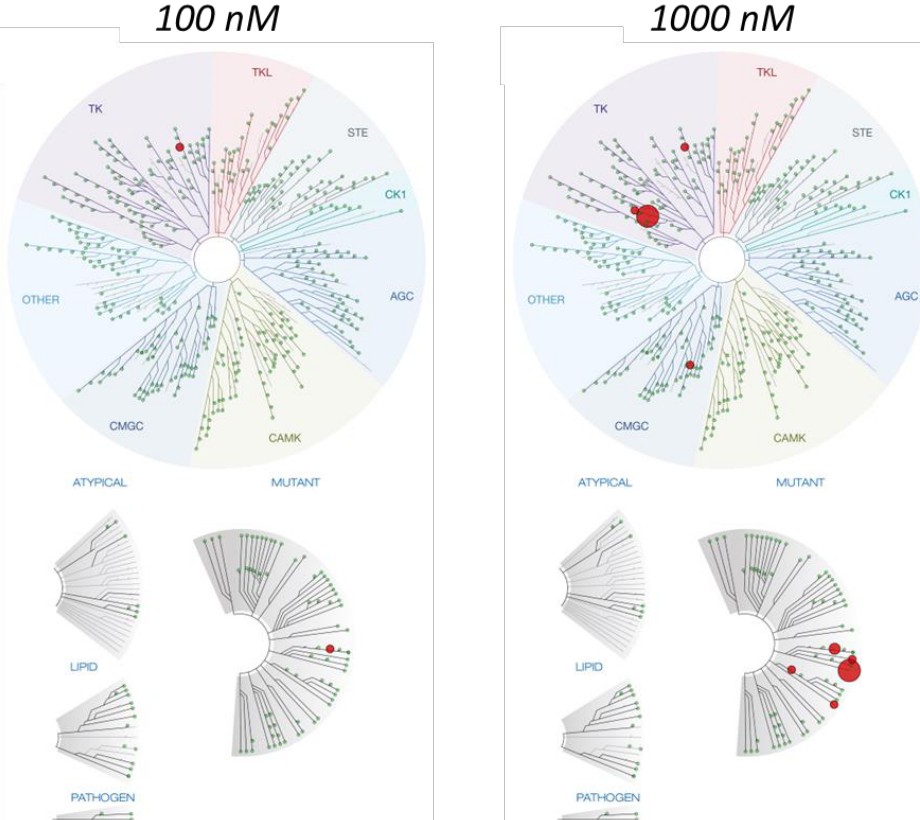
Figure 4. The TREEspot TM interaction map of compound 26 in the 468-kinase scanMAXSM panel at 100 and 1000 nM. The panel includes 403 unique wild-type kinases and 59 mutant isoforms. Note that PERK is not included in the TREEspot assay. Complete tabulated results presented in Supplemental Table S2.